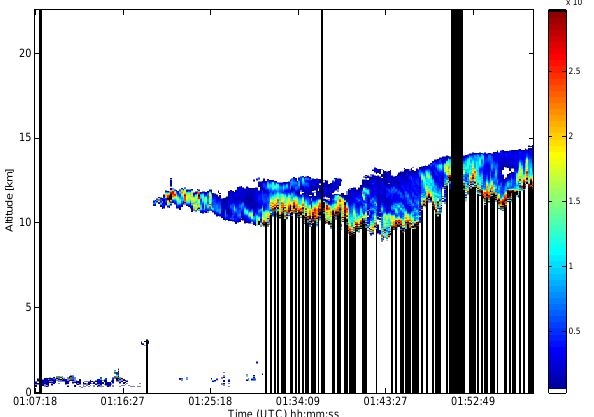
Fig. 9. CPL extinction cross section from 01:07 to 01:54UTC on the 23 February 2003. Pixels with integrated optical depth smaller than 0.02 are coloured white. Black pixels are those with integrated optical depth greater than 2.98, that is where the signal is saturated, or to pixels for which no CPL measurement is available.